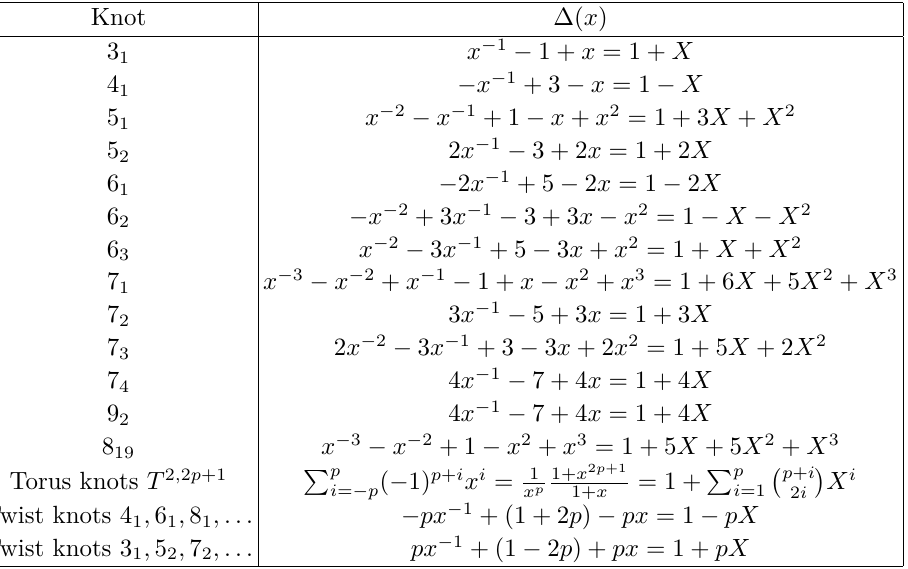
Table 1 . Alexander polynomials ∆( x ) for various knots, written as a function of x and in terms of X = (1 − x ) 2 x